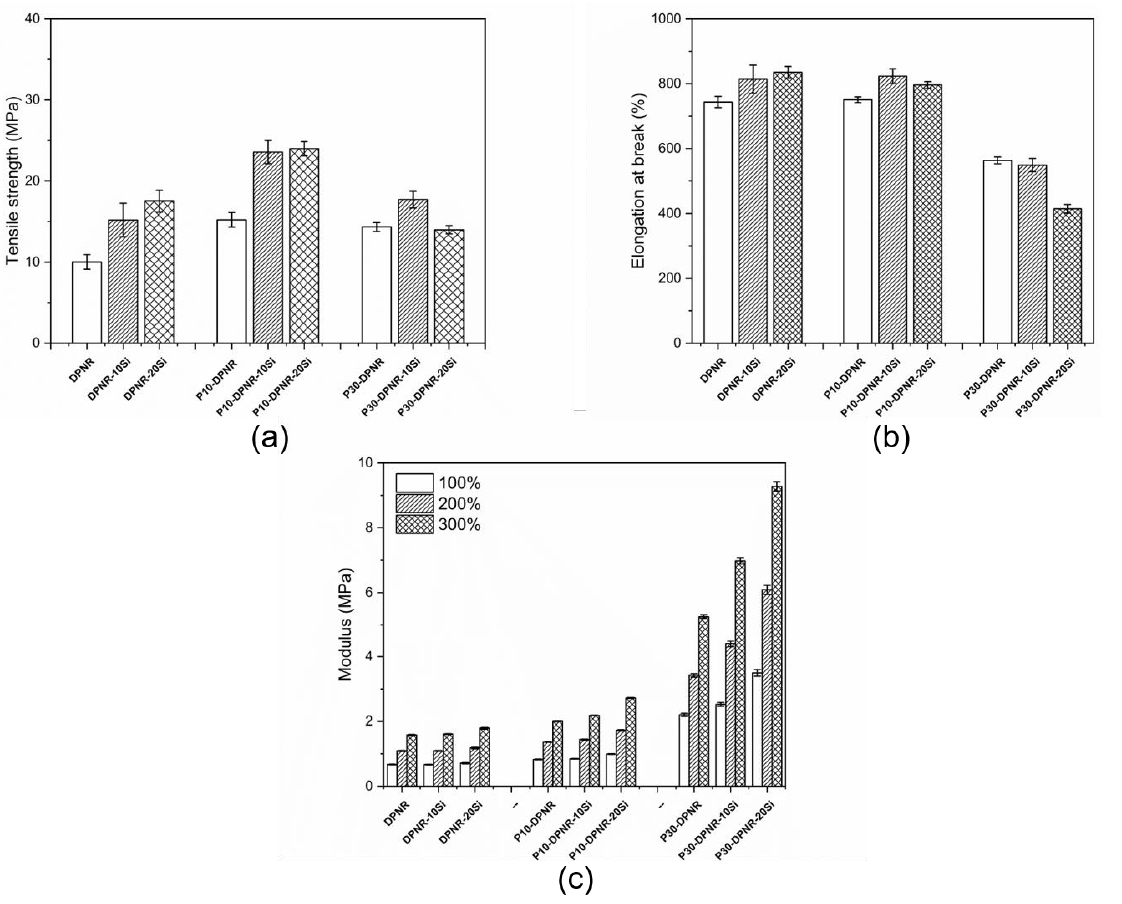
Figure 15. ( a ) Tensile strength; ( b ) elongation at break; and ( c ) modulus at 100, 200, and 300% strain of the silica-filled natural rubber composites.